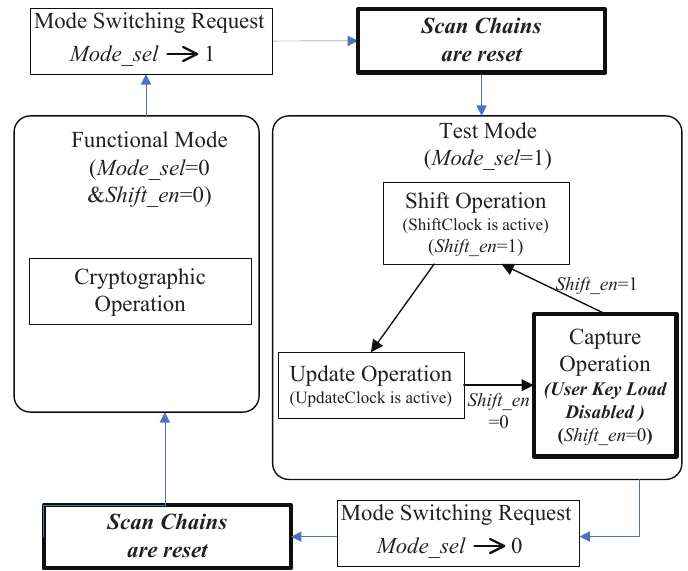
Figure 8. State diagram of proposed secure scan test